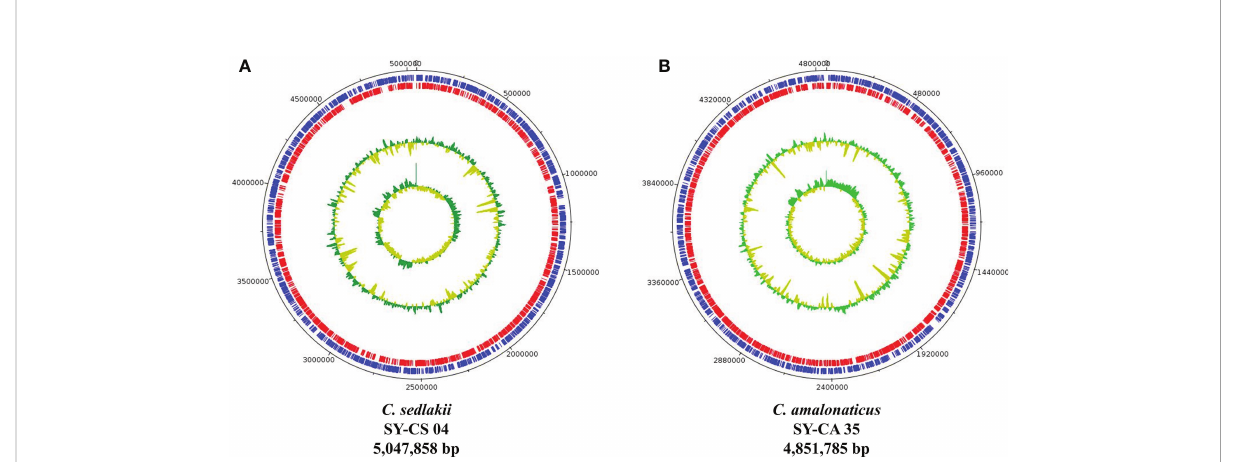
FIGURE 2 Overview of genomic structure of Citrobacter isolates. (A) Citrobacter sedlakii SY-CS04. (B) Citrobacter amalonaticus strain SY-CA35. The inner circle and outer circle represent GC skew and GC content, respectively. The protein-coding gene on forward strand and reverse strand represent in blue and red, respectively.